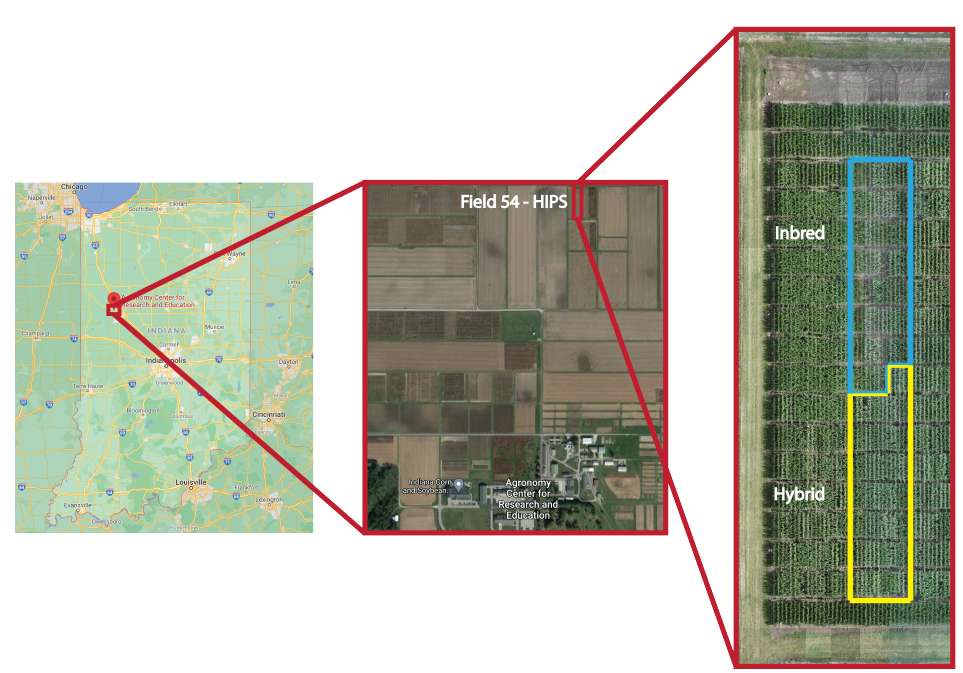
Figure 1. Experimental site: the field trials at Agronomy Center for Research and Education (ACRE).